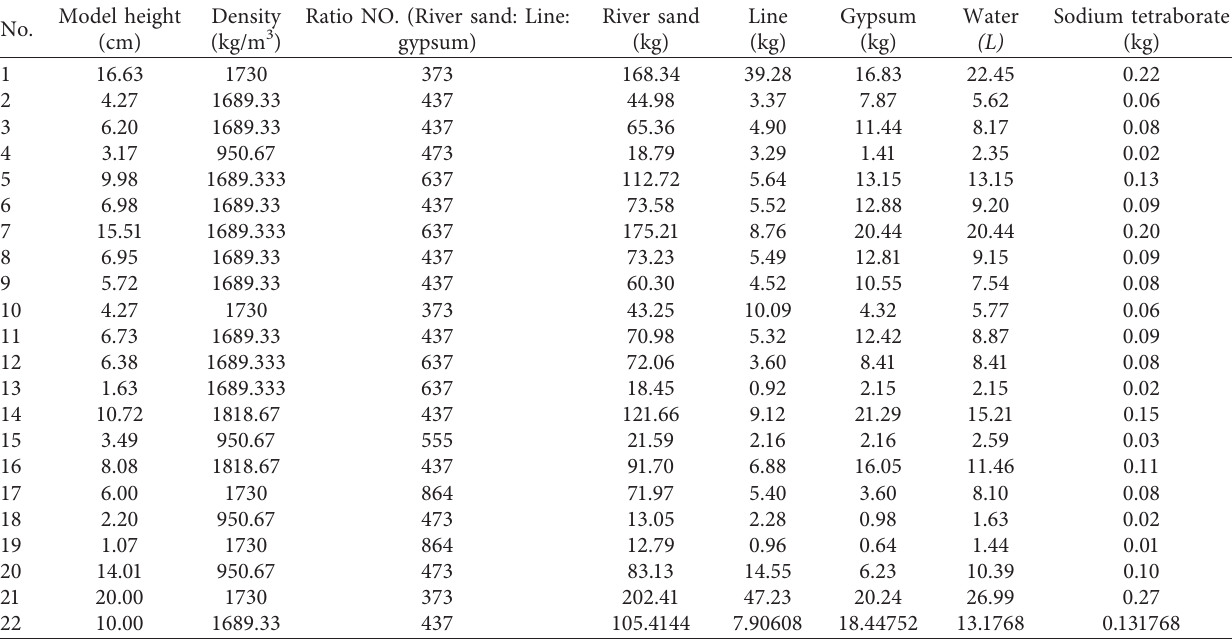
Table 4: Similar material proportioning of 8101 working